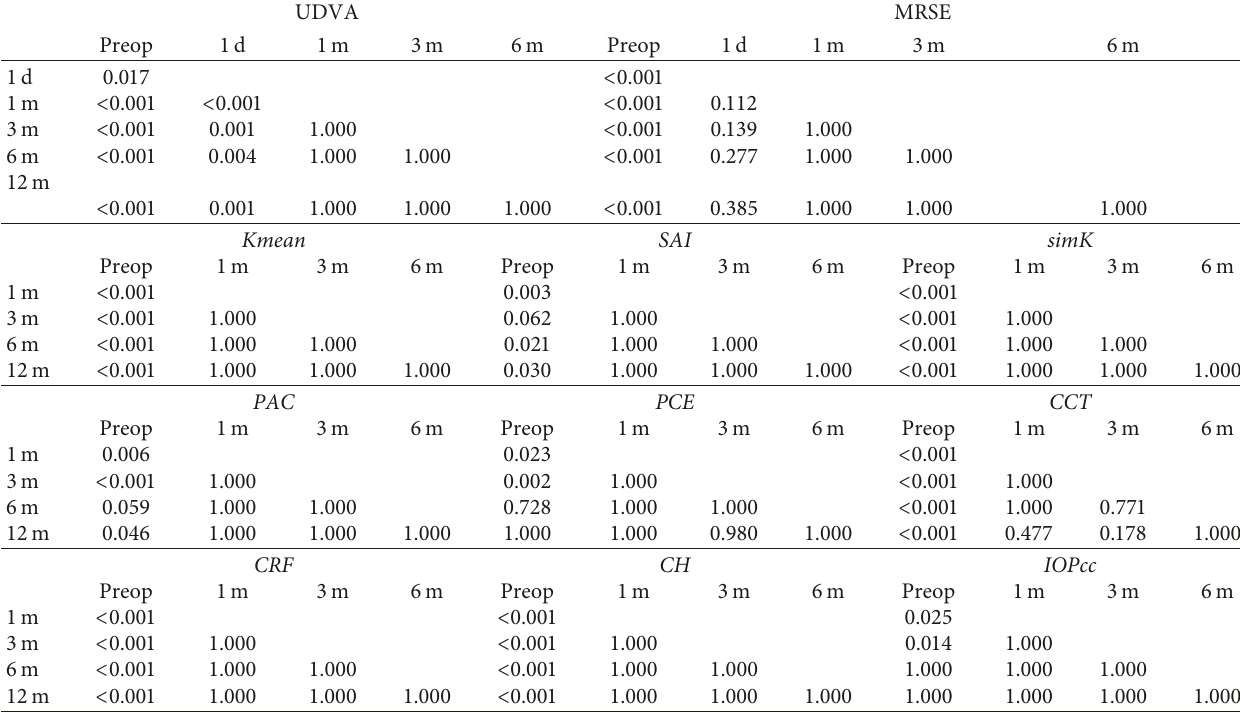
Table 3: The differences at 1, 3, 6, and 12 months after SMILE Xtra